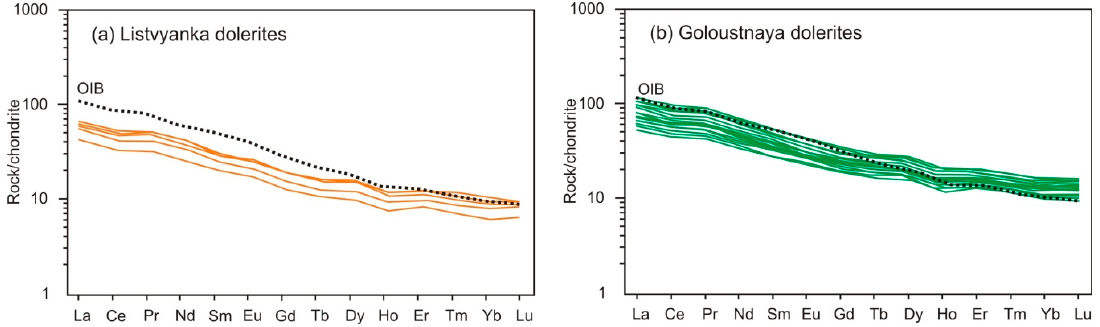
Figure 8. Chondrite ‐ normalized [37] REE patterns for Listvyanka ( a ) and Goloustnaya ( b ) dolerites. The oceanic island basalts (OIB) pattern is after Sun and McDonough [36].